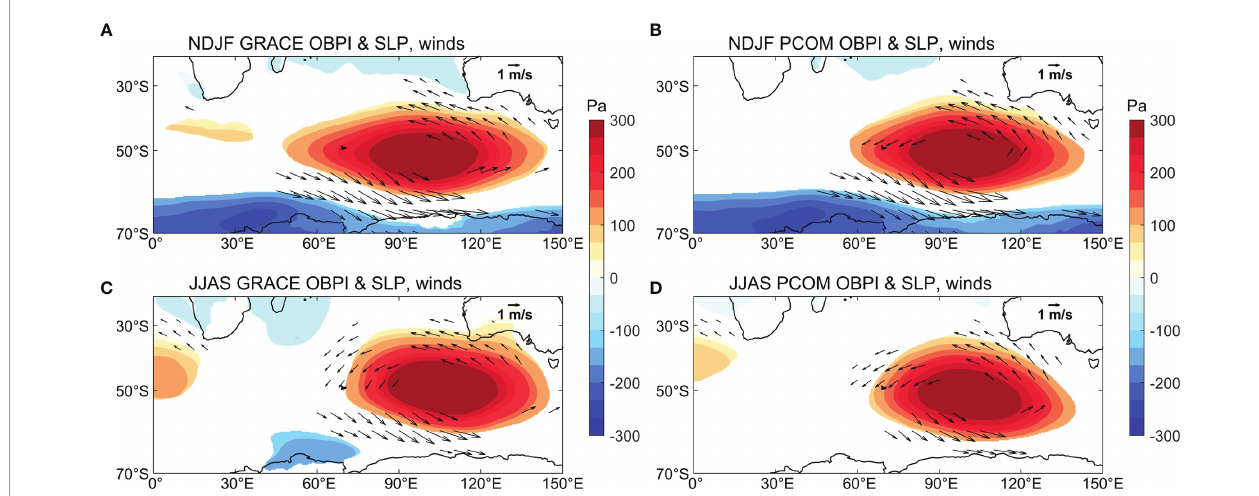
FIGURE 4 | Regression coef fi cients of SLP anomalies (color) and 10 m winds (vector) on the (A) normalized NDJF-averaged GRACE OBPI and (C) normalized JJAS- averaged GRACE OBPI. (B) and (D) are identical to (A) and (C) but on PCOM OBPI. Only anomalies are signi fi cant at the 95% signi fi cance level are